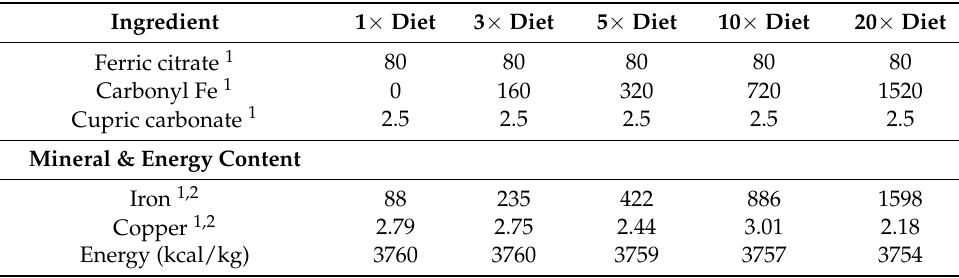
Table 2. Iron and copper composition and content, and energy density of experimental diets.